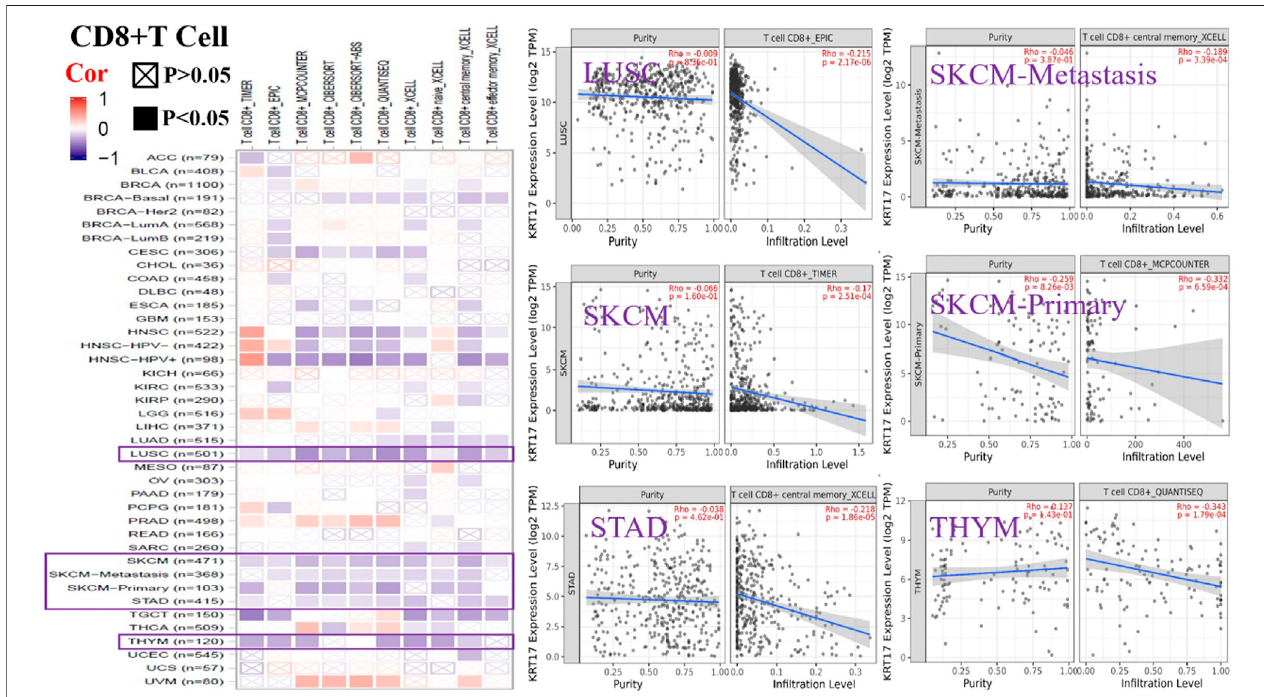
FIGURE8| CorrelationbetweenKRT17expression andimmunein fi ltration ofCD8+Tcells.InLUSC,SKCM,SKCM-metastasis,SKCM-primary,STADandTHYM and KRT17 expression was negatively correlated with CD8+T cell expression (TCGA